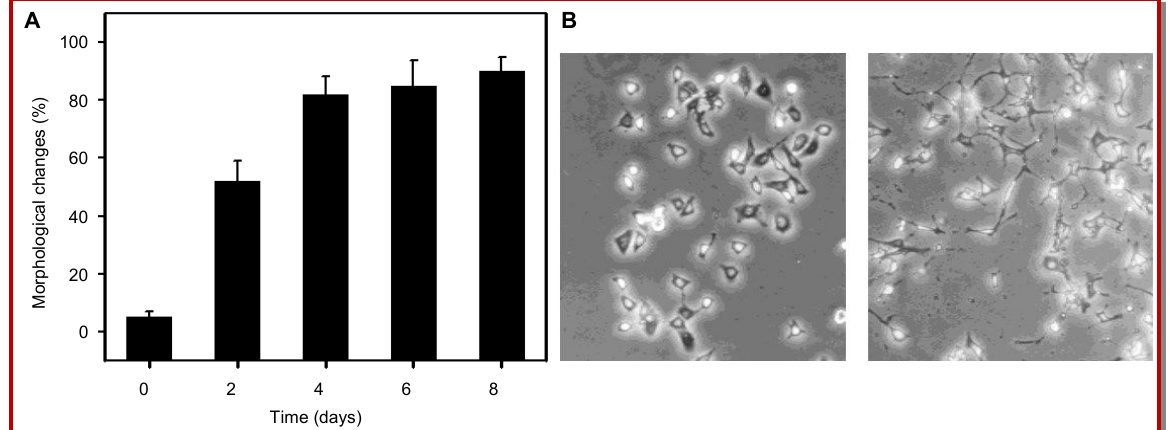
Figure 2: A. Neuronal characteristics of DU145 cells with 100 nM midostaurin treatment at different time intervals. The values given are the mean of triplicate experiments with standard deviation. B. Microscopic observations of the morphological appear- ances in DU145 cells. Phase-contract microscopic images of DU145 cells (i) untreated and 100 nM midostaurin treated cells for (ii) for 72